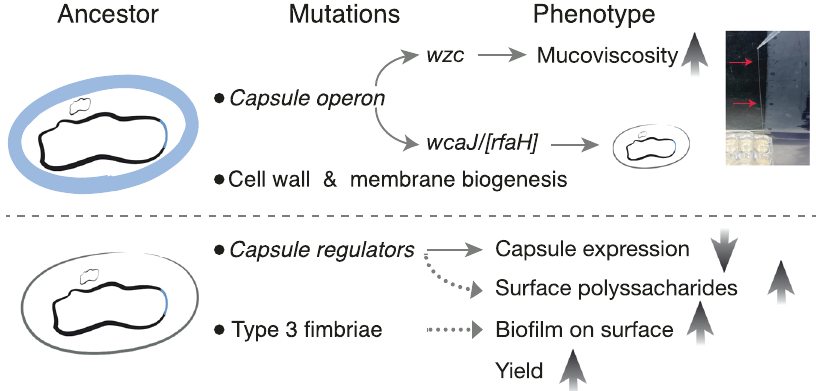
Fig. 7 | Model of Klebsiella adaptation to structured environments. Capsulated populations adapt by mutations in the capsule operon, which commonly result in increased hypermucoviscosity, and to a lesser extent, capsule inactivation. Addi- tional mutations were found in genes associated with the cell wall and membrane biogenesis. The picture illustrates a positive string-test, a hallmark of HMP identi- fi cation, performed in liquid. A long bacterialstring stemming from the wellto the